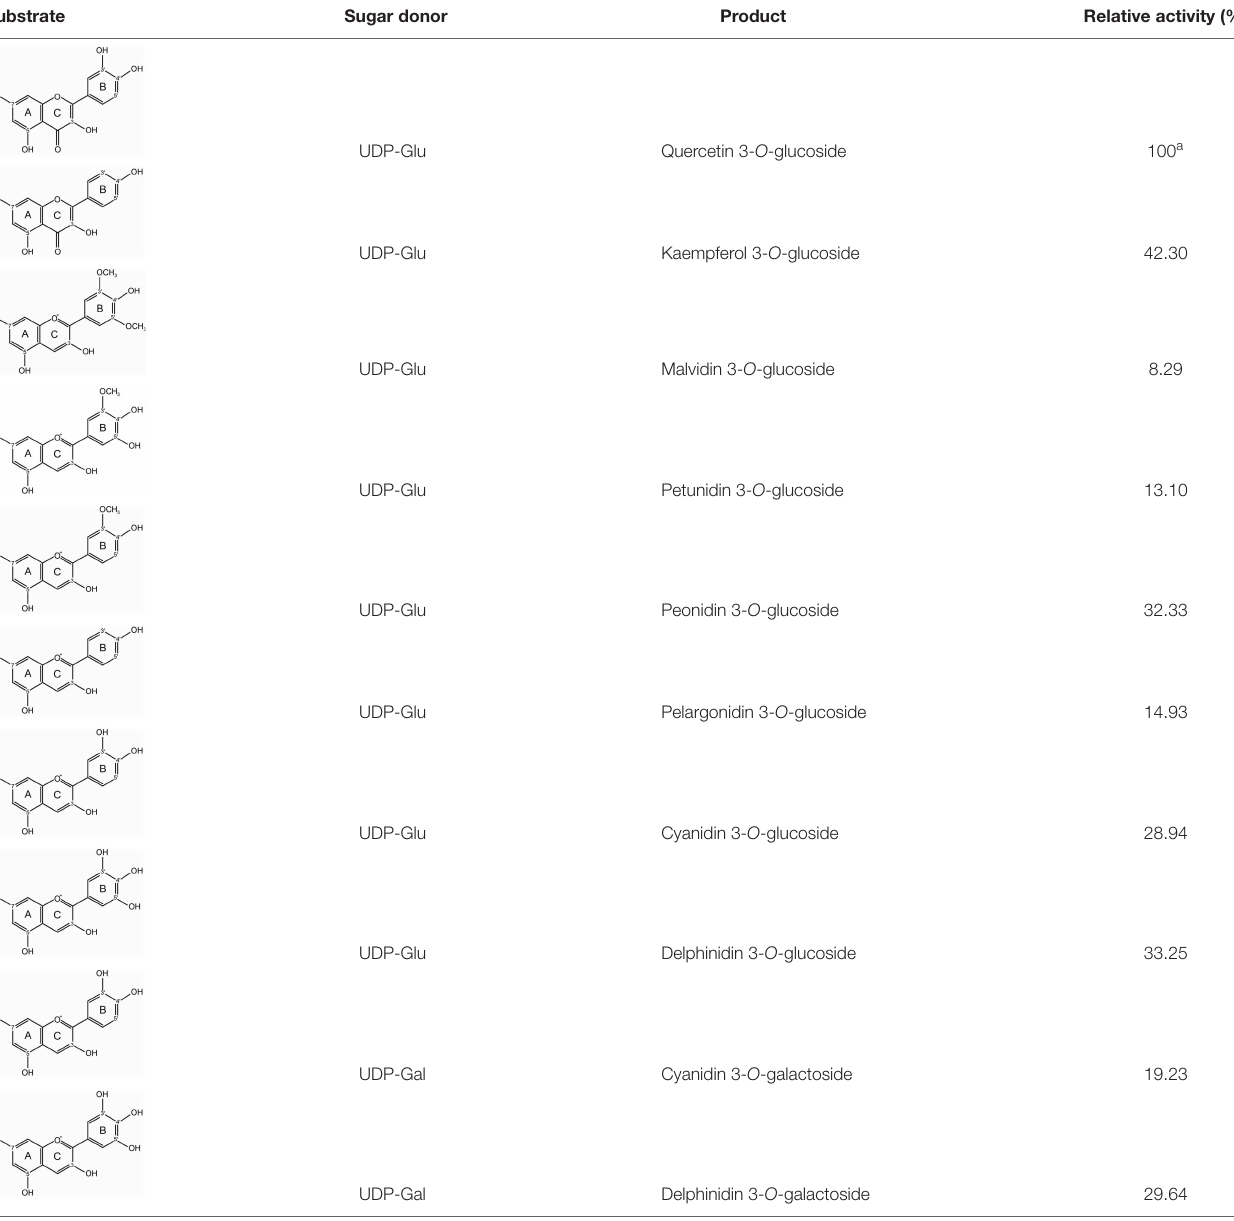
TABLE 1 | Relative activity of Fh3GT1 toward several